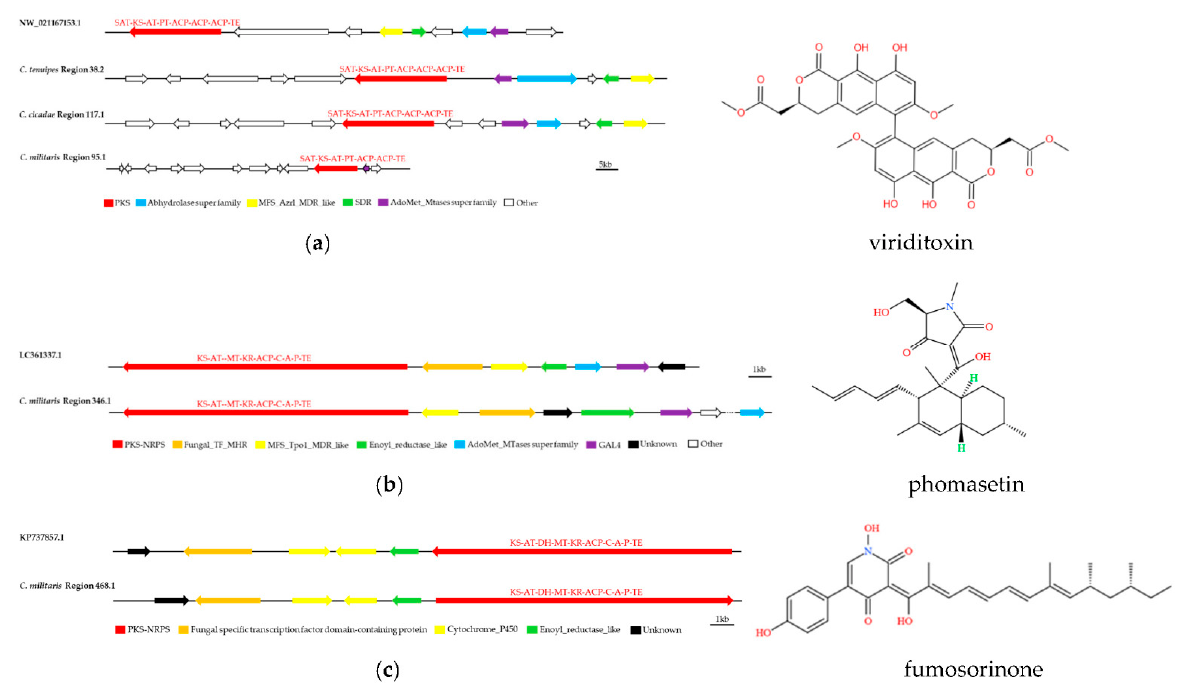
Figure 6. Comparison of biosynthesis of putative viriditoxin ( a ), phomasetin ( b ), and fumosorinone ( c ) biosynthetic gene clusters. The number after the region and the number before the decimal point represent the scaffold, and the number after the decimal point represents the gene cluster.